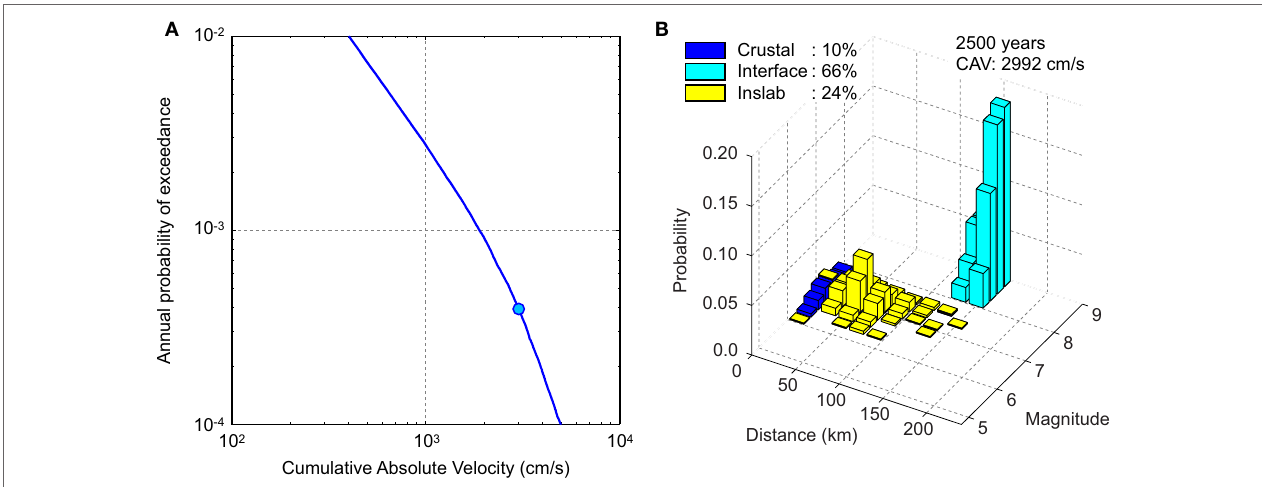
FIGURE 10 | Cumulative absolute velocity-based seismic hazard results: (A) seismic hazard curve and (B) seismic hazard disaggregation .